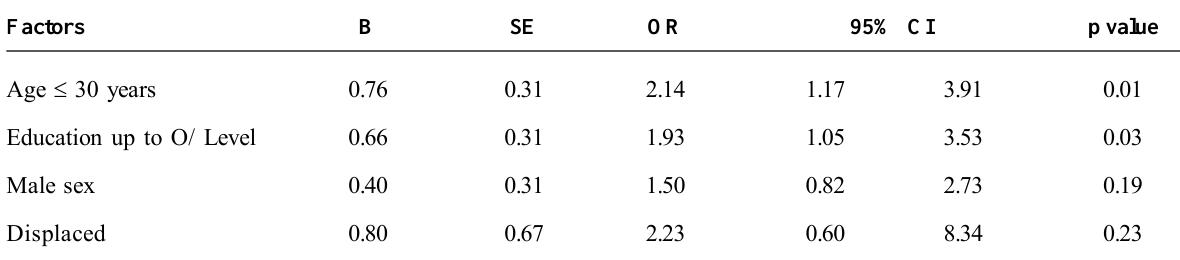
Table 2. Factors associated with internal migration by multiple logistic regression analysis